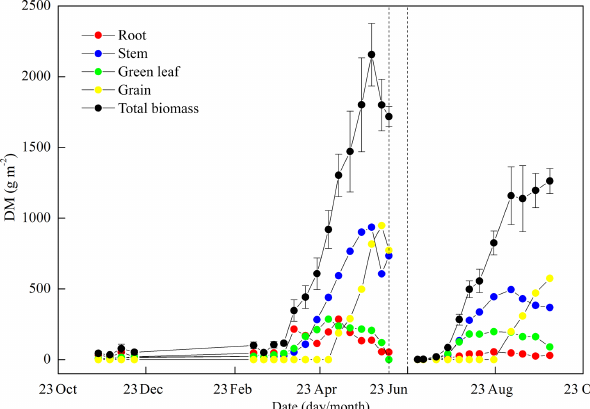
Figure 5. Seasonal variations in canopy height ( H c ) and leaf area index (LAI). The error bars denote 1 standard deviation of the 10 points.